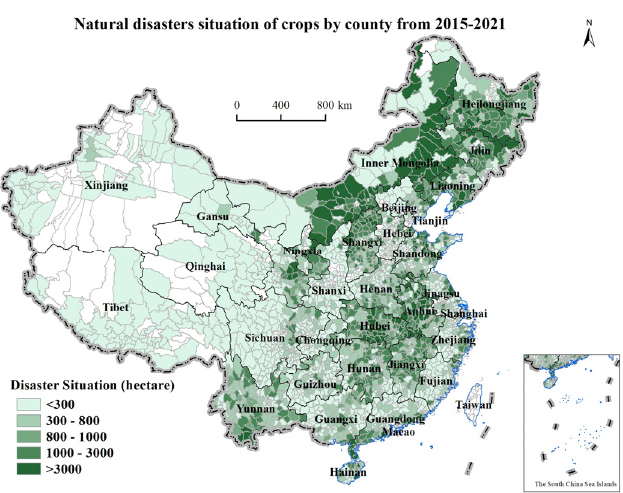
Figure 3. The geographic regionalization.